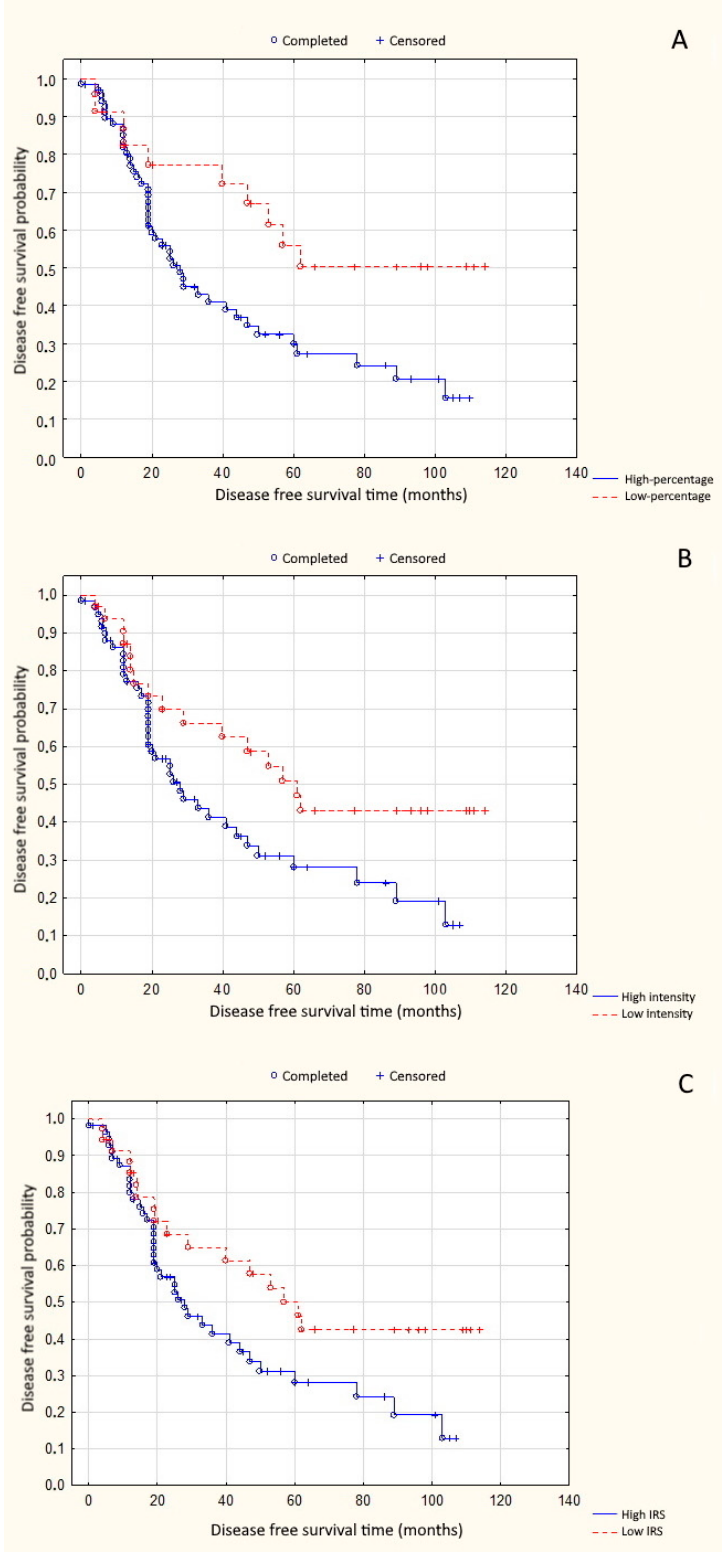
Figure 3. ( A ) Correlation between PARP-1 percentage of positive cells and disease-free survival time ( p = 0.012); ( B ) correlation between PARP-1 reaction intensity and disease-free survival time ( p = 0.028); and ( C ) correlation between PARP-1 total expression and disease-free survival time ( p = 0.039).